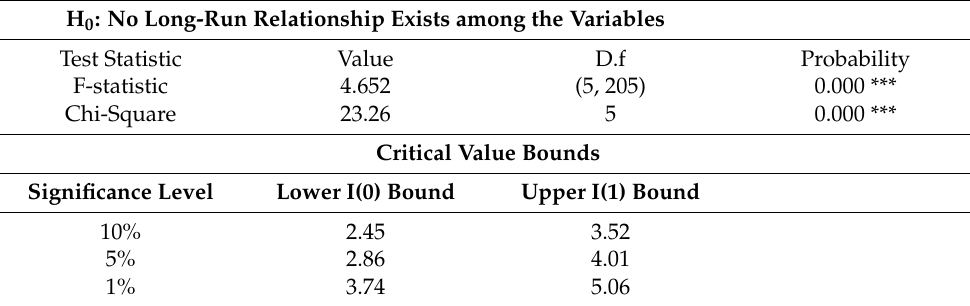
Table 5. Wald test of the series: INP, INF, EDU, PRO, DEP,